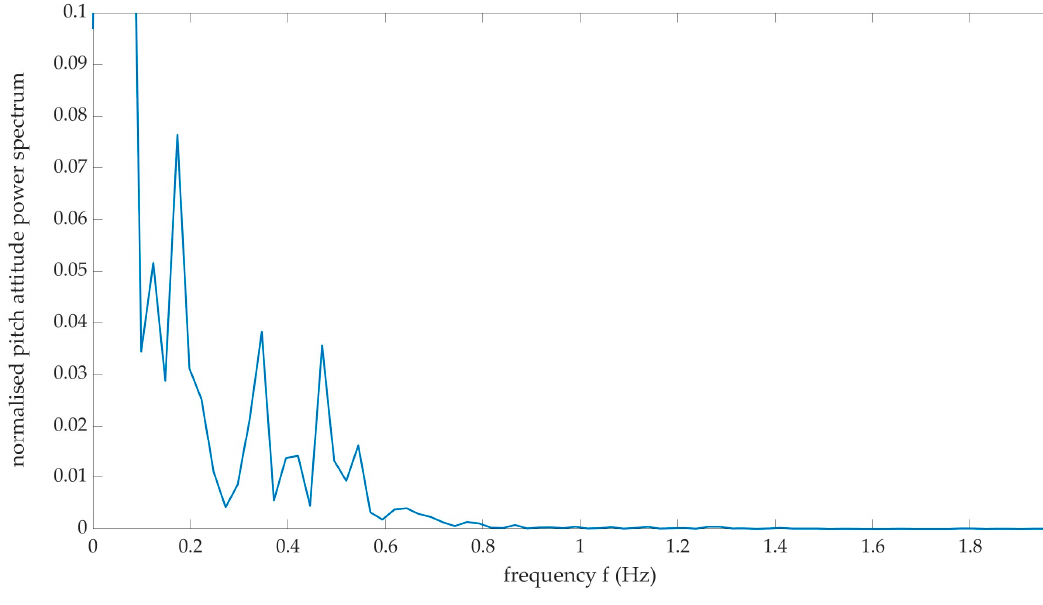
mm. The maximum displacement occurred when the pilot unloaded the tailplane to re- cover from the stall at 41.3 s in the sequence. A shorter sample window from 30 s–40 s is also shown in Figure 10, where peak oscillations during the buffet had y -displacements of − 7.48 mm to +4.49 mm, when the aircraft was heavily stalled, with significant buffet. In all cases, the negative tailplane y -displacement originates from the tailplane load, which acts in a negative y-direction, to counter the moment generated between the aerodynamic cen- ter and the center of gravity of the aircraft. The oscillatory nature of the buffet on the tail- plane can be seen in the characteristic in Figure 10 and a spectra of the sample, in Figure 11. From this spectra, the lower frequency deflections of less than 1 Hz, evident in the pitch attitude data (Figures 7 and 8), can also be seen in Figure 11. As discussed previ- ously, this pitching behavior matches stability modeling and experiments reported by pre- vious authors [11,12] and which are primarily driven by the unsteadiness in the separation point of the wing, and the change in stability of the aircraft post-stall [12,13]. When under these conditions, the tailplane is not stalled and this was confirmed by a previous numer- ical model by the authors [7] and therefore the accelerations from these gross pitch oscil- lations, clearly displace the tailplane. In this tailplane spectra, there was also a second dominant peak of 9.28 Hz (Figure 11), which within experimental error, matches the nat- ural frequency of the tailplane, as shown in Figure 2. Therefore, it is clear the wake shed- ding frequency from the wing is interacting with the tailplane and within a range of angle of attack is closely matching the tailplane natural frequency. This results in this additional significant excitation of the tailplane structure, and this is structurally undesirable. Fur- ther synchronized accelerometer and camera data would be required to investigate any potential phase modulation behavior of the wake with the tailplane, by comparison of the image and accelerometer time series. These measurements are planned in future work.